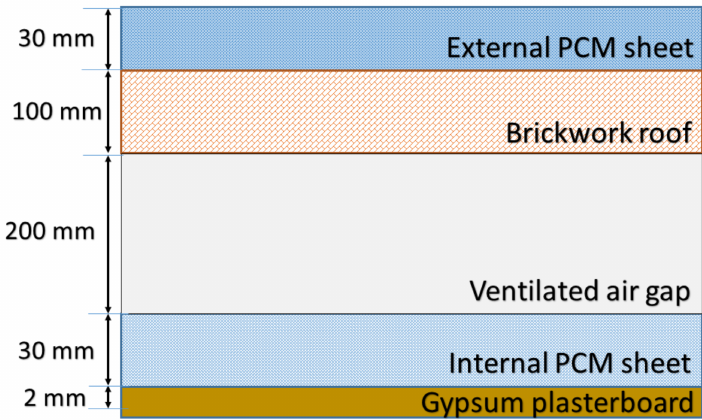
Figure 6. Ventilated roof with multilayer PCM cross-section